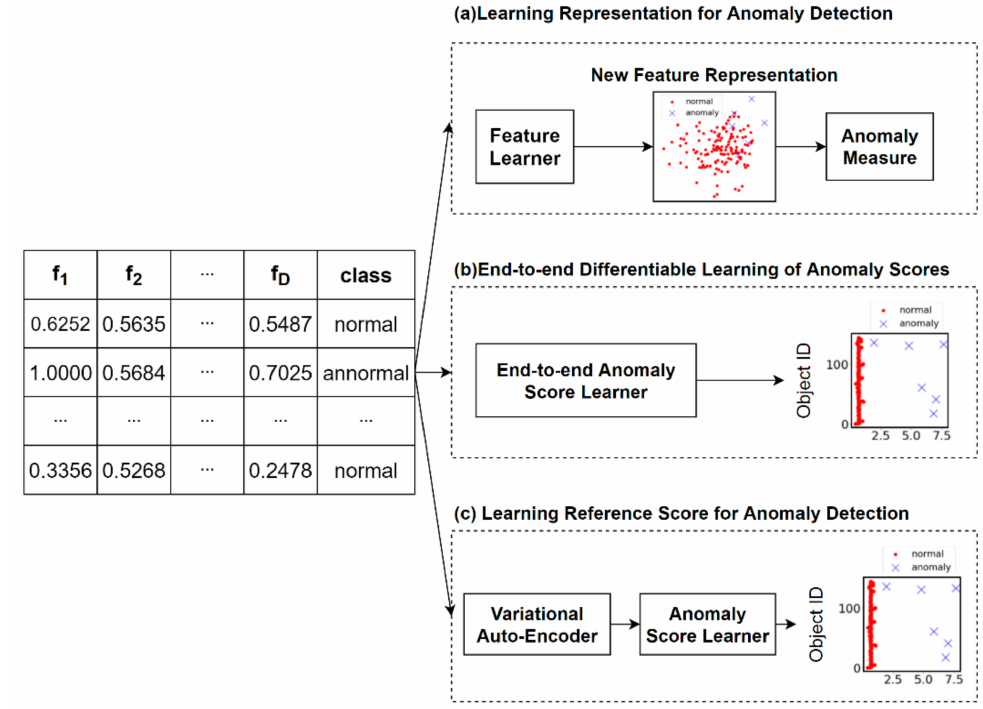
Figure 1. ( a ) Learning features for subsequent anomaly measures vs. ( b ) direct learning of anomaly scores vs. ( c ) learning reference score for subsequent anomaly